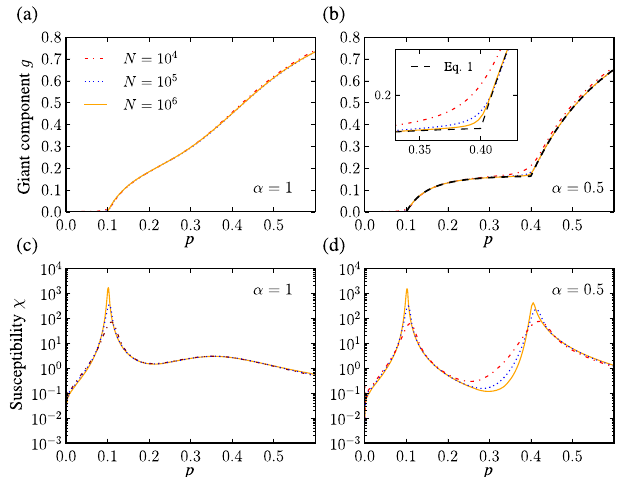
FIG. 5. Bond percolation simulations for the core-periphery random graph model with α ¼ 1 (left column) and α ¼ 0 . 5 (right column). In both cases, the core has an average degree of ¯ 2 . 5 . The core-periphery ratio is r ¼ 0 . 2 . k and the periphery p ¼ The black dashed line in plot (b) is the numerical solution of ¯ 0 . The inset shows the approach to the k Eqs. (1) and (2) with cp ¼ theoretical prediction at the second transition point as the size of the system is